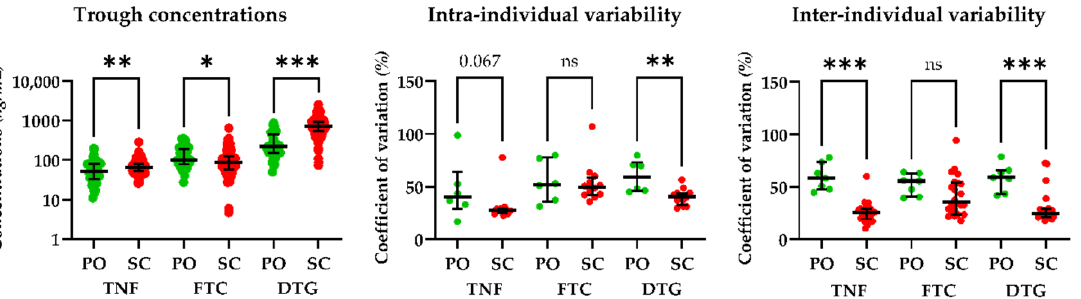
Figure 3. Steady-state trough concentrations depending on the route of administration and the intra- and inter-individual variability. The boxplot graphs represent trough concentrations (left), intra- individual variability (middle), and inter-individual variability (right); continuous lines represent the median and interquartile range values. Statistically significant differences are indicated as fol- lows: * p < 0.05, ** p < 0.01, *** p < 0.001, ns: non-significant. Abbreviations: TNF: tenofovir, FTC: emtricitabine, DTG: dolutegravir, PO: oral route, SC: subcutaneous route.